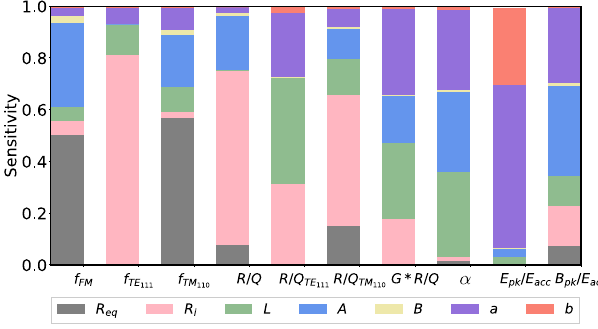
FIG. 6. Main sensitivities. The intervals for the geometric parameters R eq ; R i ; L; A; B; a; b are given in Table III. The polynomial degree is p ¼ 2 , so the size of the sample is 216 [cf. Table